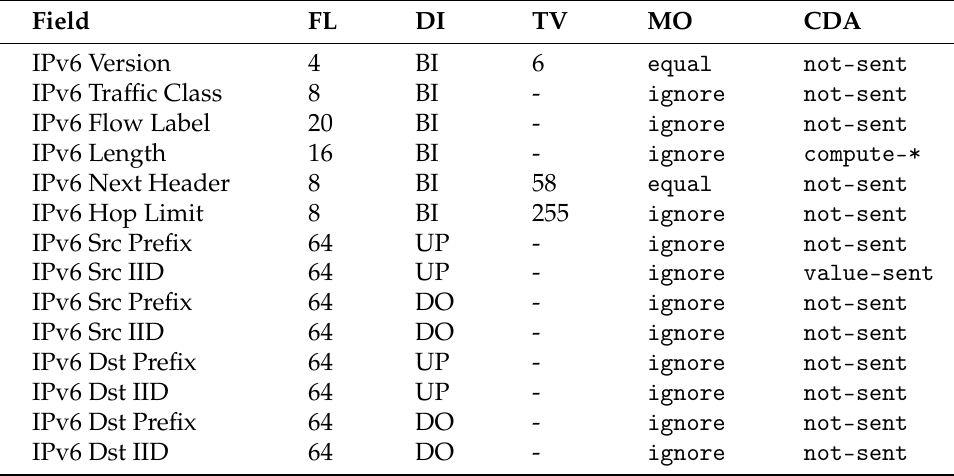
Table A1. SCHC neighbor discovery NS/NA for Ack-on-Error and